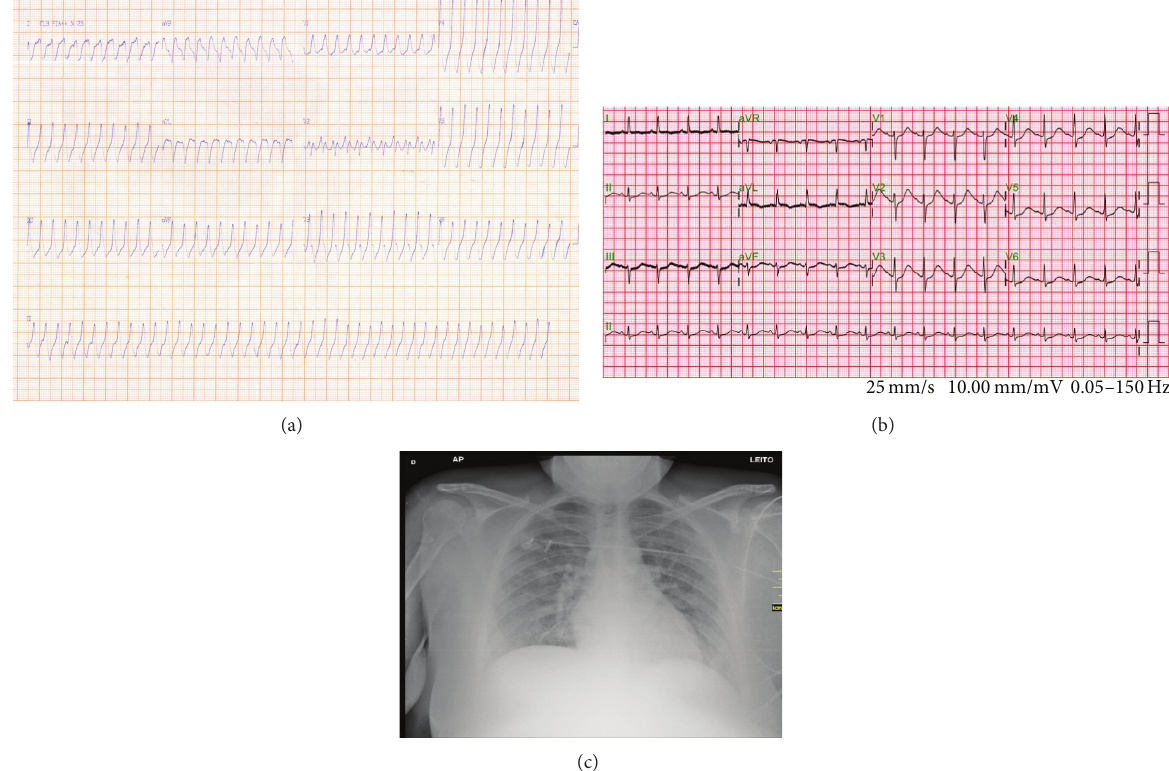
Figure 1: Electrocardiogram of a 25-year-old woman showing an episode of sustained ventricular tachycardia (SVT) with very fast heart rate (approximately 300 bpm) after scorpion envenomation (a). Upon admission to the hospital, the electrocardiogram showed sinus tachycardia associated with QTc interval prolongation (550 ms) after SVT reversal (b). A chest radiograph shows pulmonary edema with a normal cardiac area